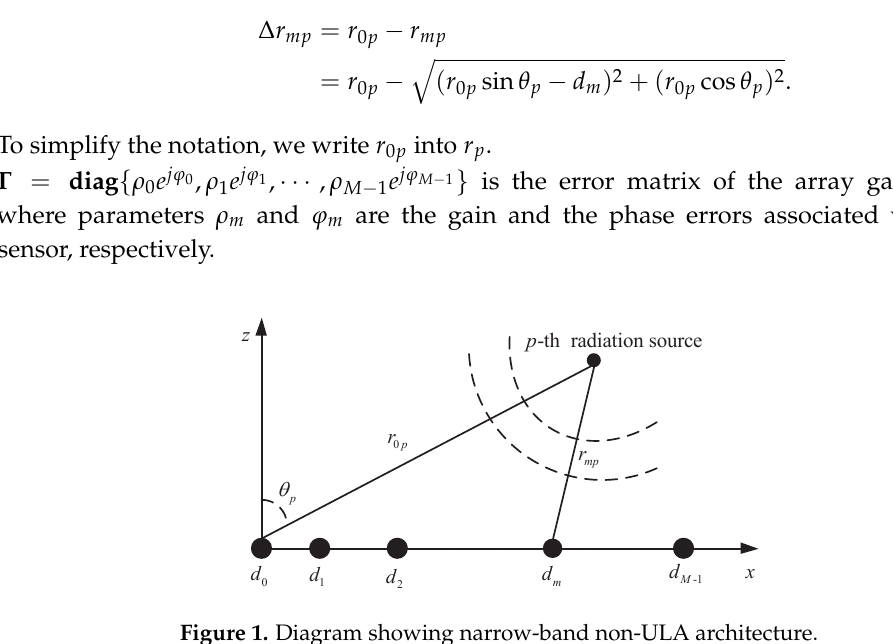
Figure 1. Diagram showing narrow-band non-ULA